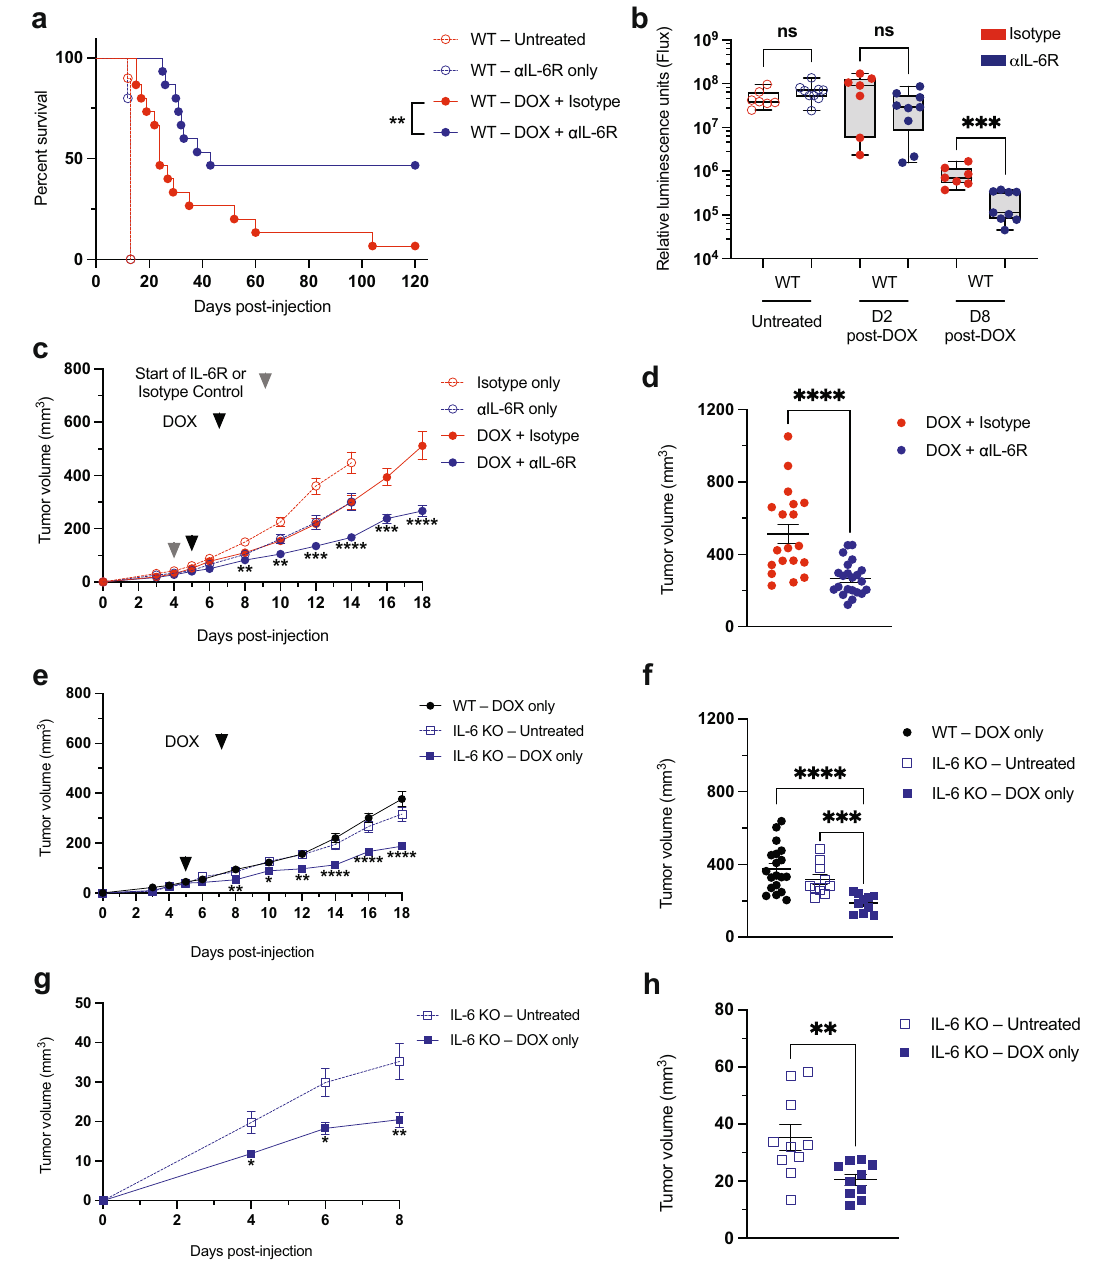
Fig. 6 Therapeutic IL-6 inhibition enhances the ef fi cacy of doxorubicin treatment. a A Kaplan – Meier survival curve of B-ALL-bearing mice. n = 15 for